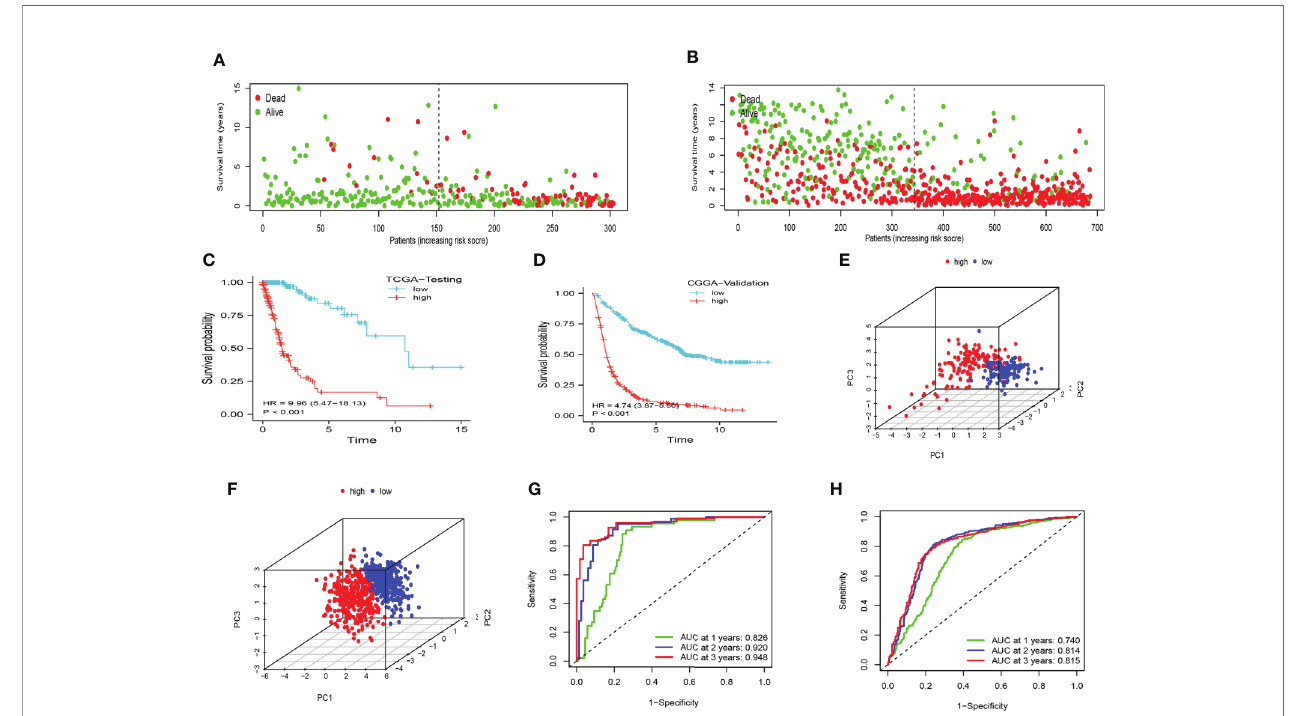
FIGURE 4 | The accuracy of the DDRGs signature was veri fi ed using internal and external validation. (A, B) Scatter plots depicting the survival and status of patients in the high- and low-risk groups in TCGA testing and CGGA validation datasets. (C, D) Survival curve was used to analyze OS in the low- and high-risk groups in TCGA testing and CGGA sets. (E, F) Principal component analysis (PCA) of the DDRG signature in TCGA testing and CGGA sets. (G, H) ROC curves were constructed for TCGA testing and CGGA sets. CGGA, Chinese Glioma Genome Atlas; DDRG, DNA damage repair gene; OS, overall survival; ROC, receiver operating characteristic; TCGA, The Cancer Genome